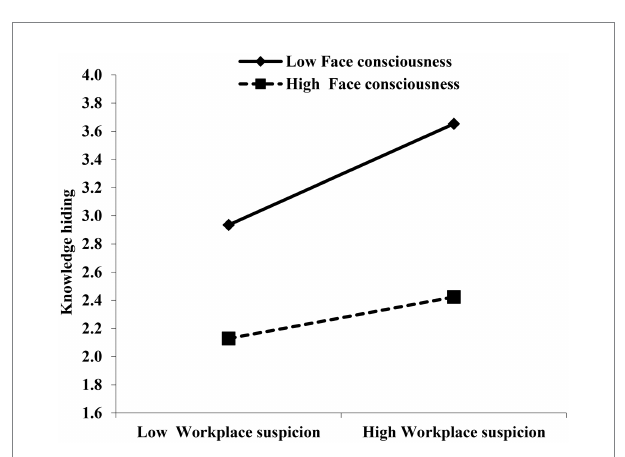
FIGURE 3 The moderating effect of face consciousness on the relationship between workplace suspicion and knowledge hiding.